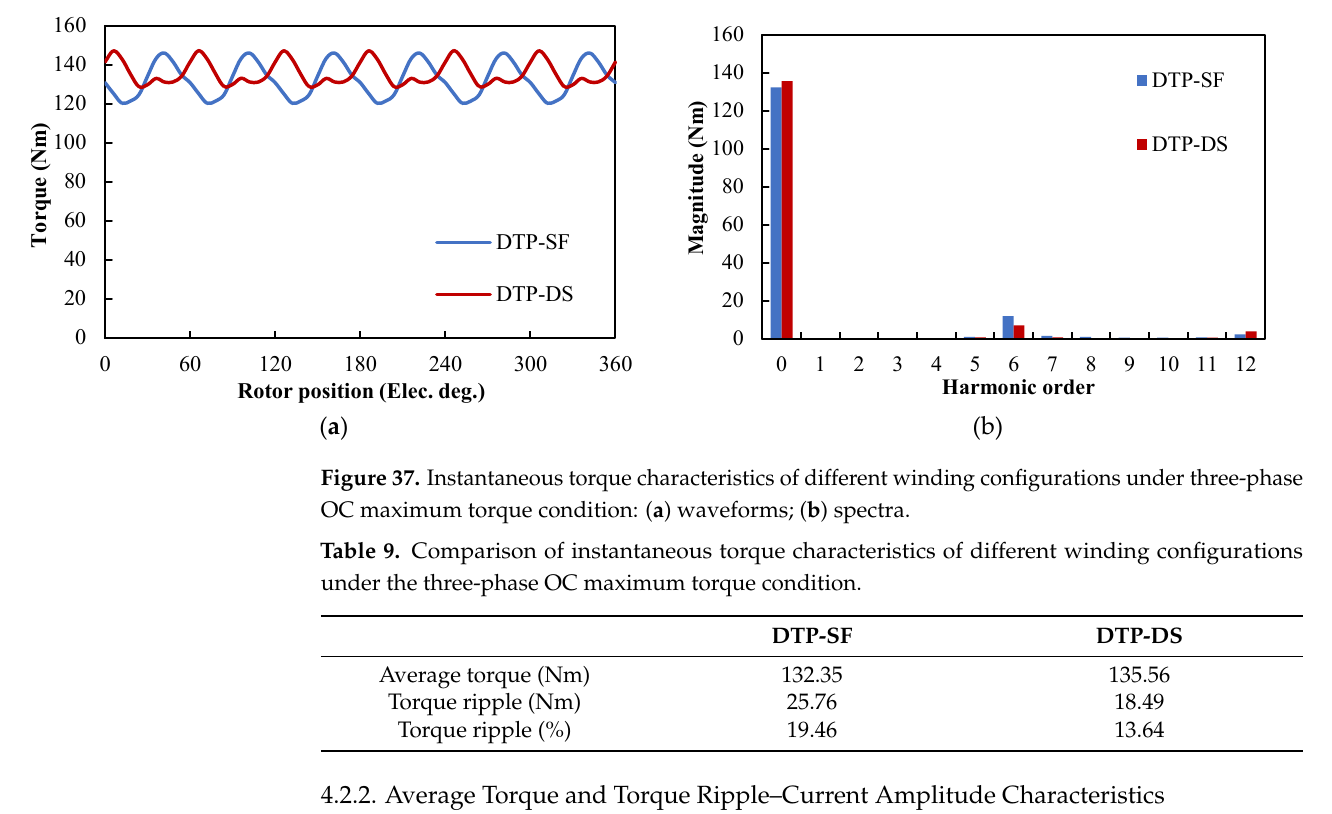
( b ) Figure 36. Winding layouts of remaining winding set in DTP machines: ( a ) DTP-SF; ( b ) DTP-DS. 4.2. Torque 4.2.1. Instantaneous Torque Waveforms As discussed before, the instantaneous torque characteristics of the two winding con- figurations are examined under the maximum torque condition. The phase currents in the remaining windings are 118 Apk, and the current advancing angle is set to produce the highest output torque. The waveforms and spectra of the instantaneous torque under this condition are shown in Figure 37, and the key characteristics are listed in Table 9. From Figure 37 and Table 9, it can be seen that the average output torque of the DTP-DS winding configuration is higher than that of the DTP-SF counterpart, while the torque pulsation of the DTP-DS winding configuration is lower. From Figure 37b, it is observed that the sixth torque harmonics cannot be eliminated in both machines under this condition, and the amplitude of the sixth torque harmonic in the DTP-SF machine is higher than that in the